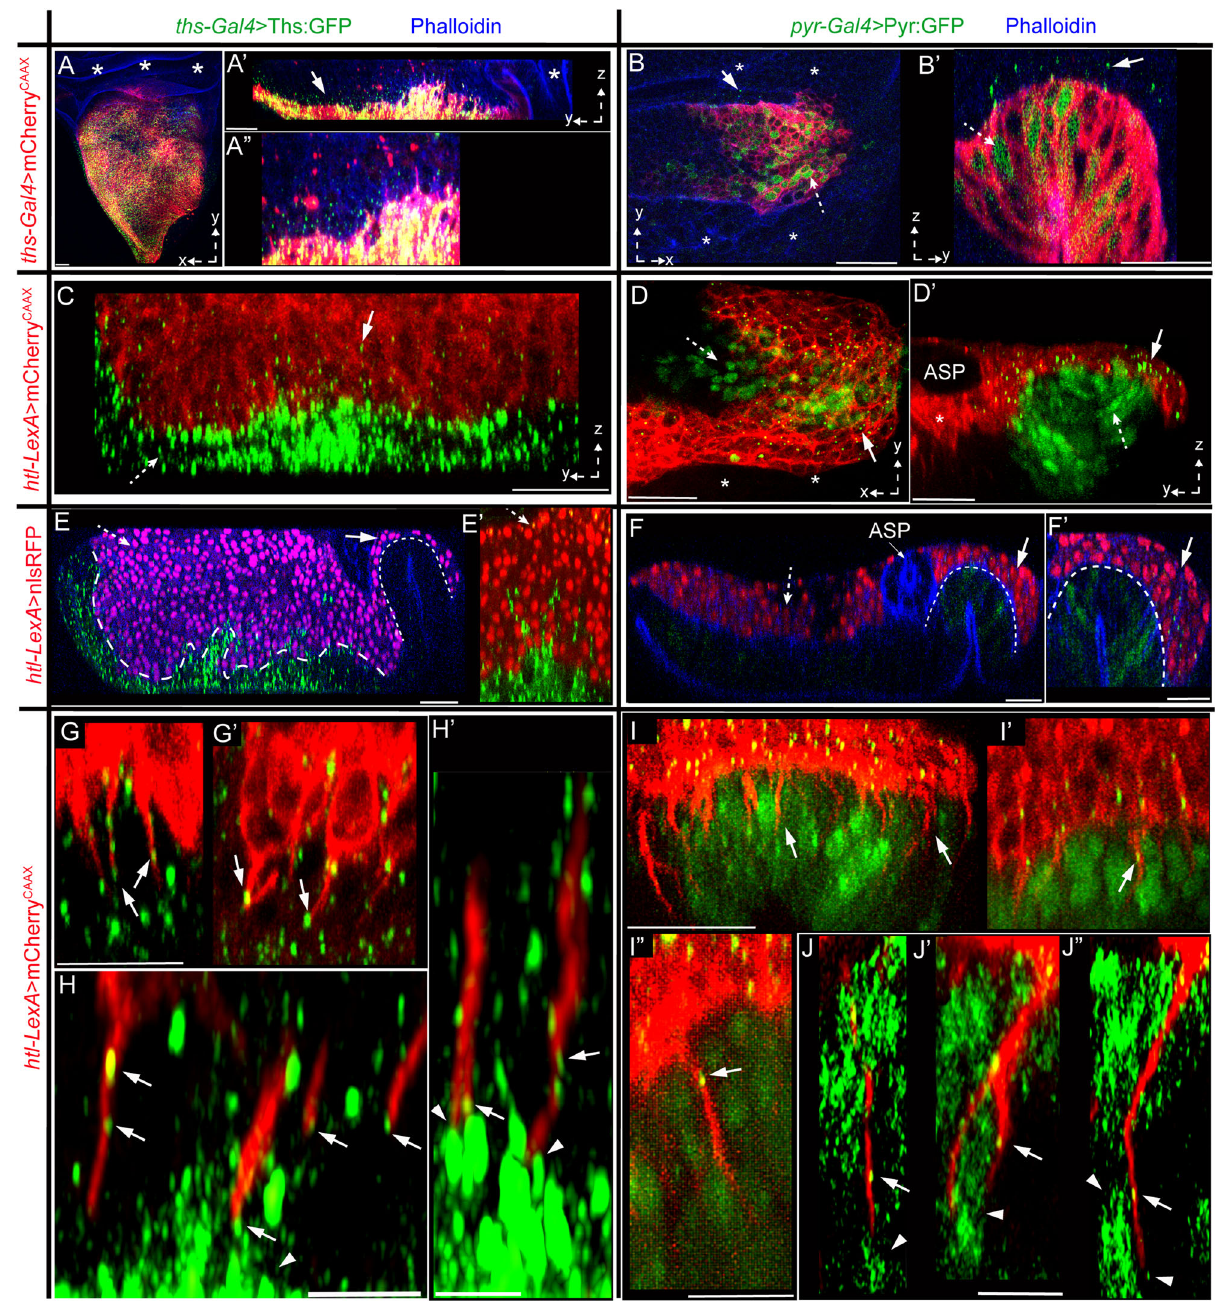
Fig. 7 Cytoneme-mediated FGF exchange generates niche-speci fi c asymmetric signaling. A , B ’ XY and YZ views (as indicated) of wing discs expressing mCherryCAAX and either Ths:GFP under ths-Gal4 ( A , A ” ) or Pyr:GFP under pyr-Gal4 ( B , B ’ ). C , D ’ Images of wing discs harboring mCherryCAAX-marked AMPs; wing discs expressing either Ths:GFP or Pyr:GFP as indicated. A – D ’ dashed arrow, signal in the source; arrow, non-autonomous punctate distribution in the AMP; *, non-expressing areas of the lacking signal distribution. E , F ’ Wing discs expressing either Ths:GFP or Pyr:GFP as indicated, showing niche-speci fi c effects of signal overexpression on proliferation of niche-resident and non-resident AMPs (nls:GFP marked); thick and thin dashed line, interface between AMPs and ths -expression and pyr -expression zones, respectively; dashed and solid arrows, effects on ths -expression and pyr - expression zones, respectively. G – J YZ views of wing discs expressing either Ths:GFP or Pyr:GFP as indicated and harboring mCherryCAAX-marked AMPs, showing disc-invading cytonemes receiving GFP-tagged signal (arrow) from the disc cells; arrowheads, localized signal enrichment in source cells. Scale bars: 20 μ m; 5 μ m ( H , H ’